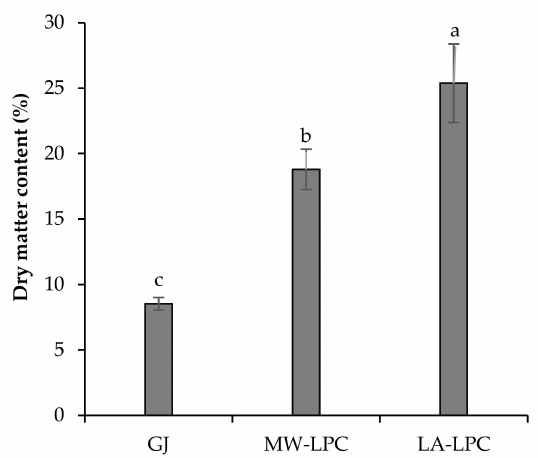
Figure 3. Dry matter content (%) of the freeze-dried fractions of the processed broccoli fresh green leaves. GJ is obtained after the mechanical pressing of the green leaves, the MW-LPC is the leaf protein concentrate obtained by the thermal coagulation of the fresh GJ using a microwave device, and LA-LPC is the leaf protein concentrate obtained by the lacto-fermentation process of the fresh GJ. Different letters on the columns show significant differences according to Tukey’s test at the level of p ≤ 0.05. Data are presented as mean ± SD ( n = 3).